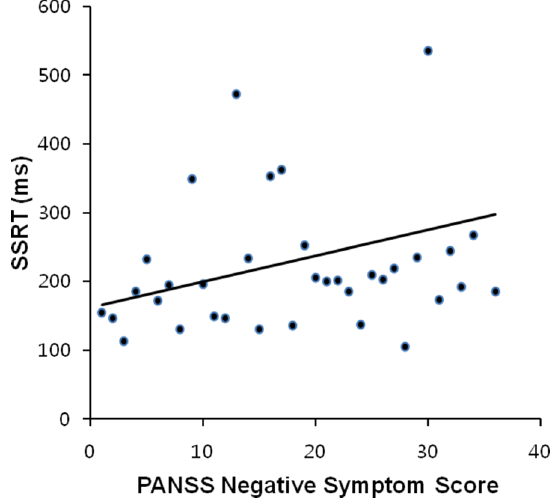
Figure 2. Mean performances in stop-signal reaction time (SSRT) of normal controls, ARMS subjects and schizophrenia patients on stop-signal task. Note. CON = control; ARMS = at-risk mental state; SZ = schizophrenia. ** p , .01.